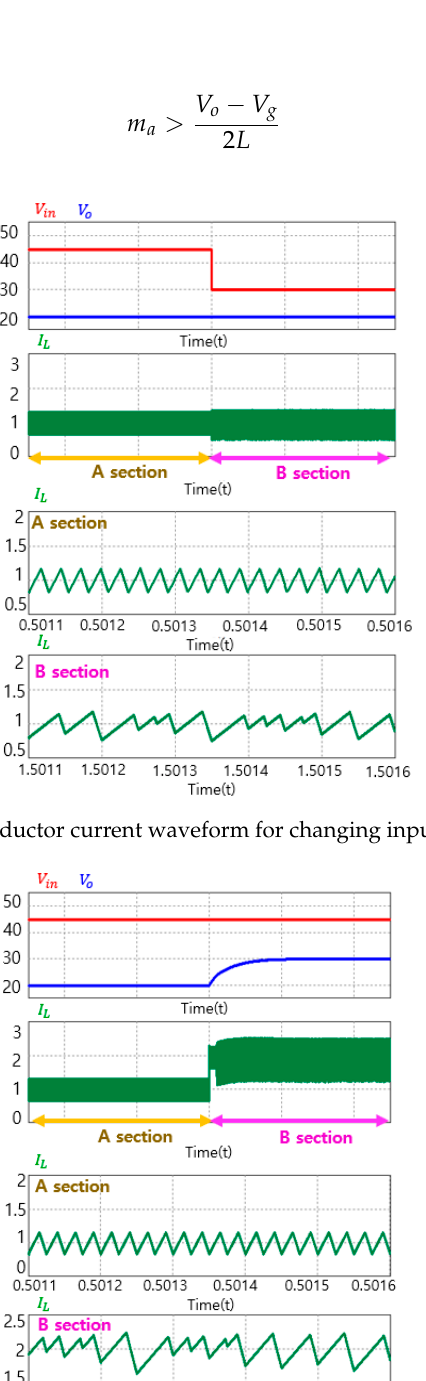
Figure 10. Duty cycle using different slopes.